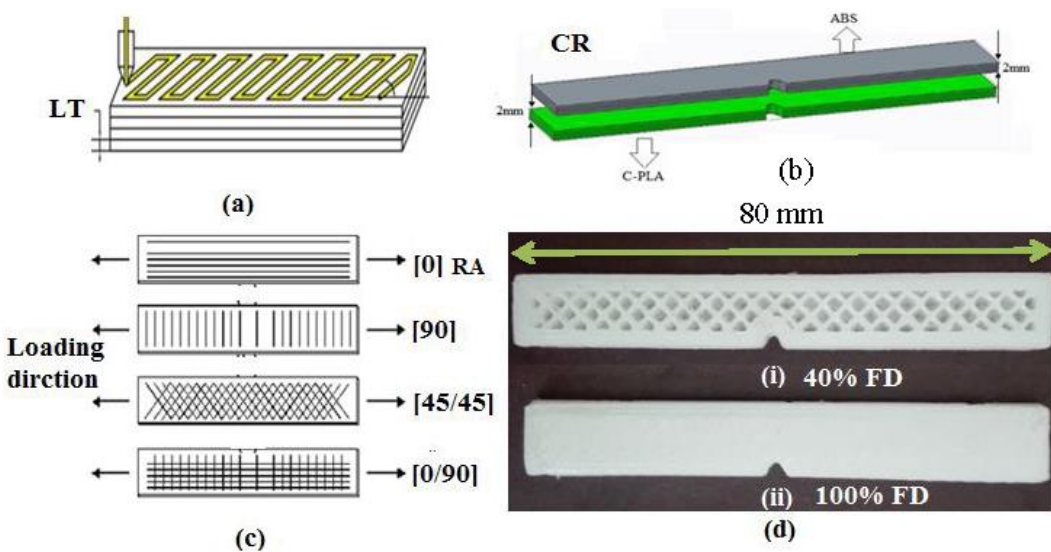
Figure 5. Four different 3D printing parameters: ( a ) layer thickness, ( b ) clad ratio, ( c ) raster angle, and ( d ) fill density.